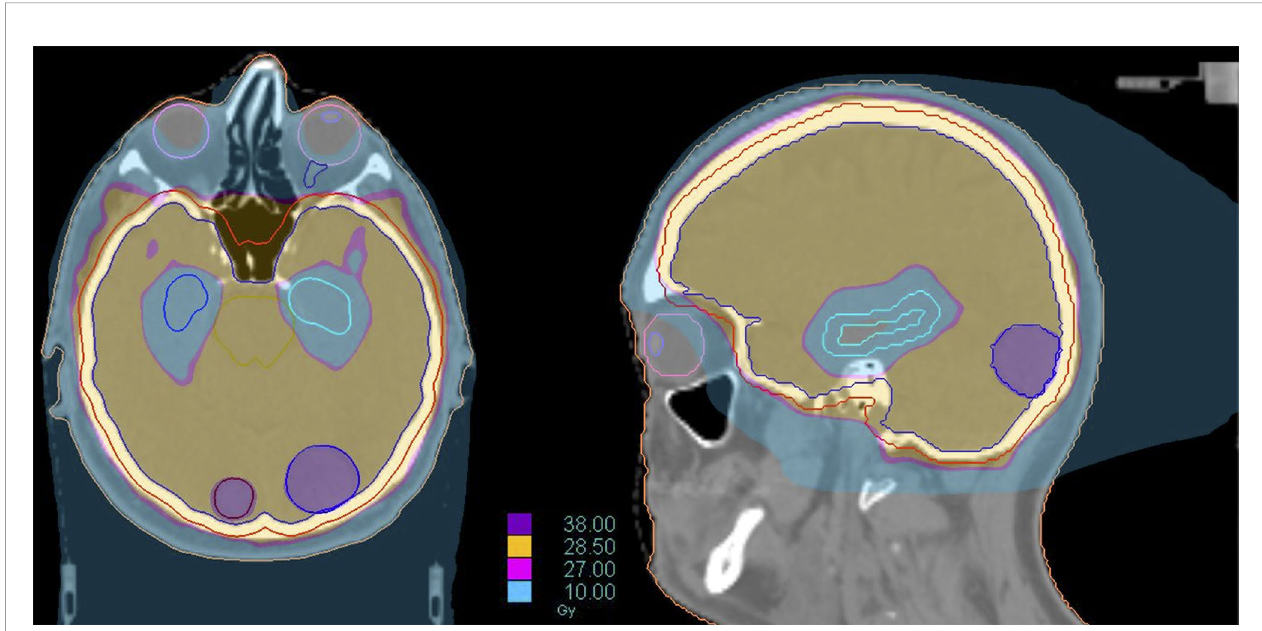
FIGURE 6 | Dose distribution of a treatment of HA-WBRT plus SIB in patient with bilateral occipital BMs (left 2 cm; right 7 mm). The treatment was delivered with Helical tomotherapy and a daily control of the patient ’ s positioning with MV-CT. The dose delivered to the whole brain was 30 Gy in 10 fx with a concomitant boost of 40 Gy in 10 fx to the 2